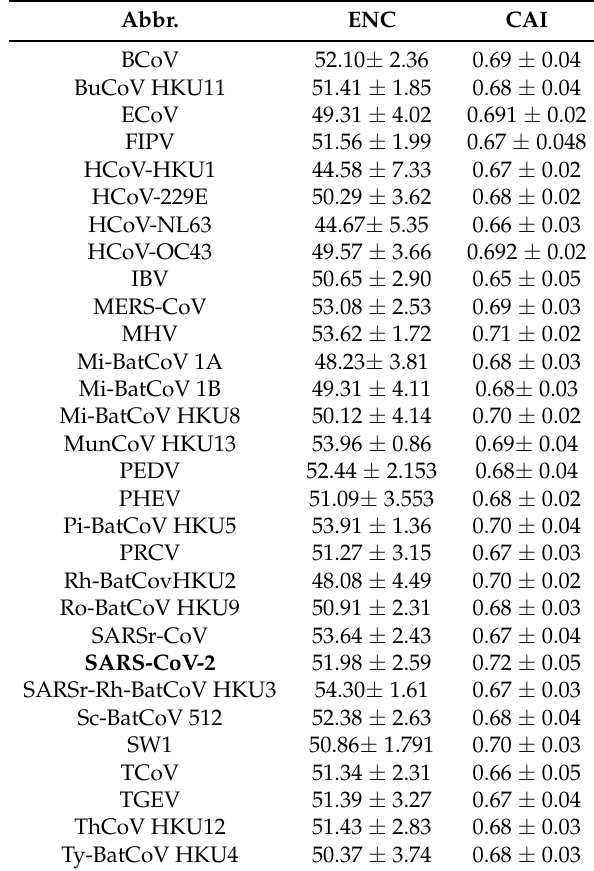
Table 3. Codon usage biases of different coronaviruses under